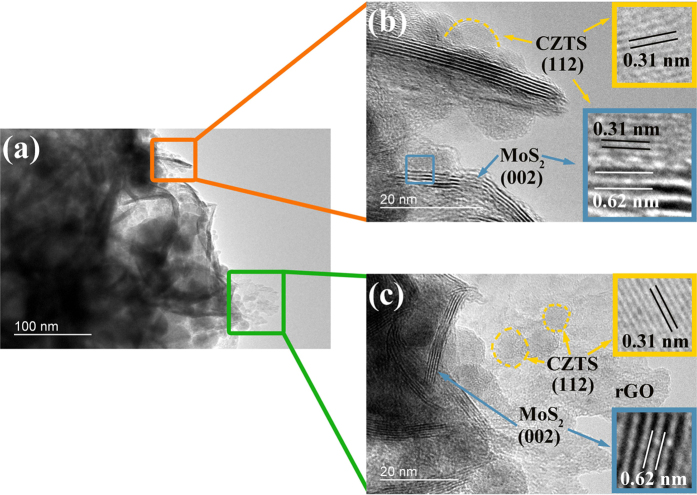
Typical (a) TEM and (b), (c) high-resolution TEM images of as-prepared CZTS/MoS2-rGO composites.